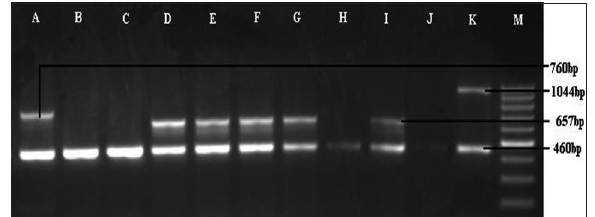
Figure-2: Multiplex-polymerase chain reaction for capsular typing of Pasteurella multocida. Lane A: Reference strain (P ). Lane D, E, F, G, and I: Sample positive for cap D. 52 Lane K: Sample positive for cap A. Lane M: 100 bp DNA Ladder.